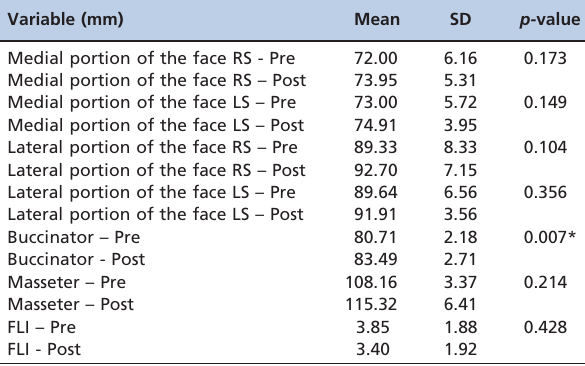
Table 1 - Summary of the anthropometric measurements and FLI